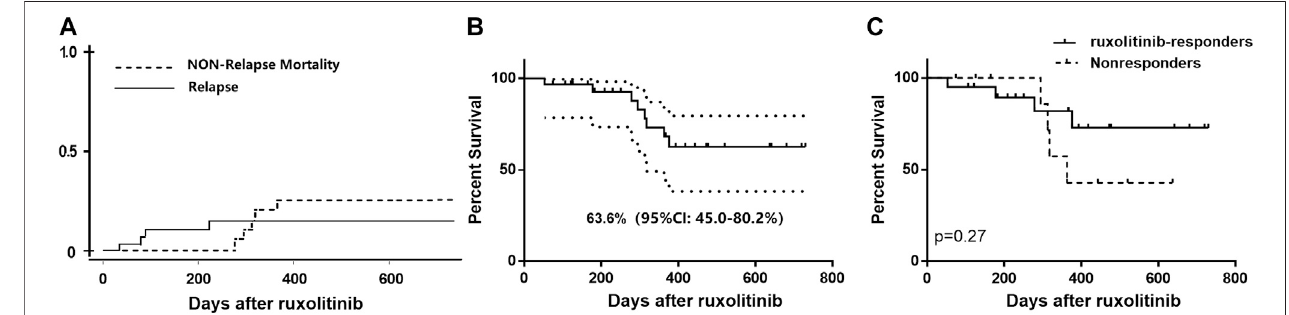
FIGURE4 | (A) Cumulative incidence of relapse and nonrelapsemortality ofall the patients with BOS receiving ruxolitinib; (B) Overall survival curve of all ruxolitinib- treated patients; (C) Overall survival of ruxolitinib-responders and nonresponders.